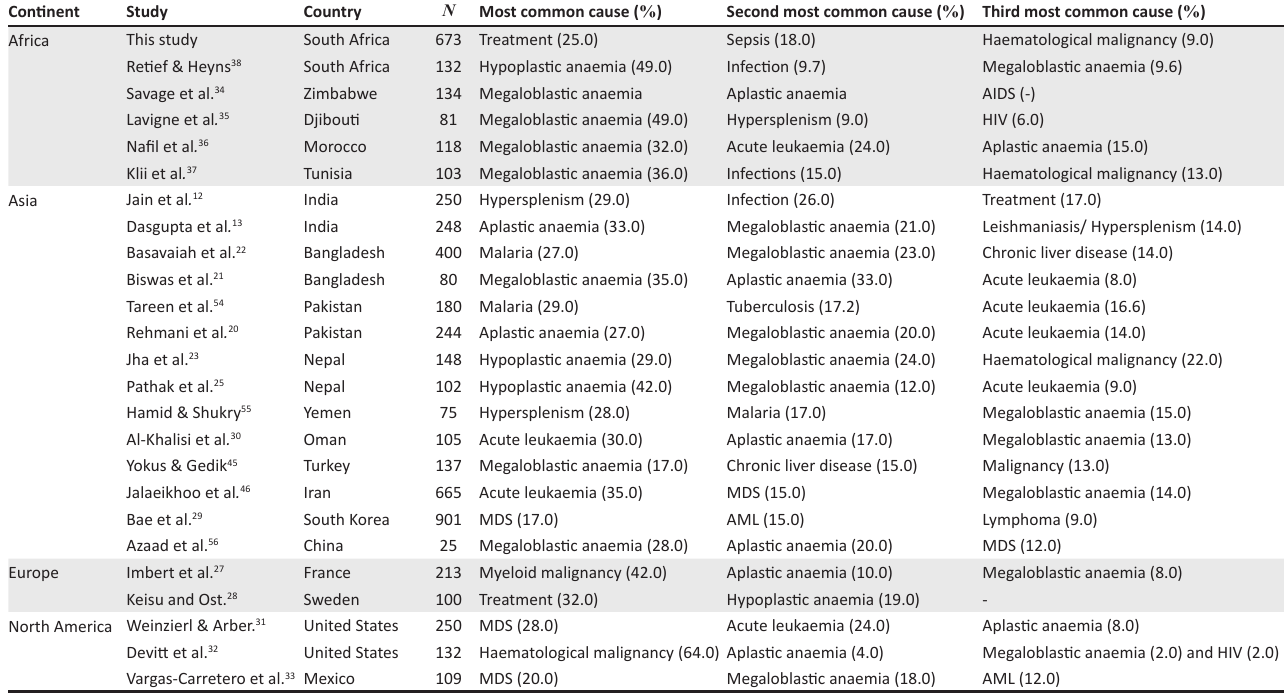
TABLE 1: Most common causes of pancytopenia across different studies globally, 1976–2019. Continent Study